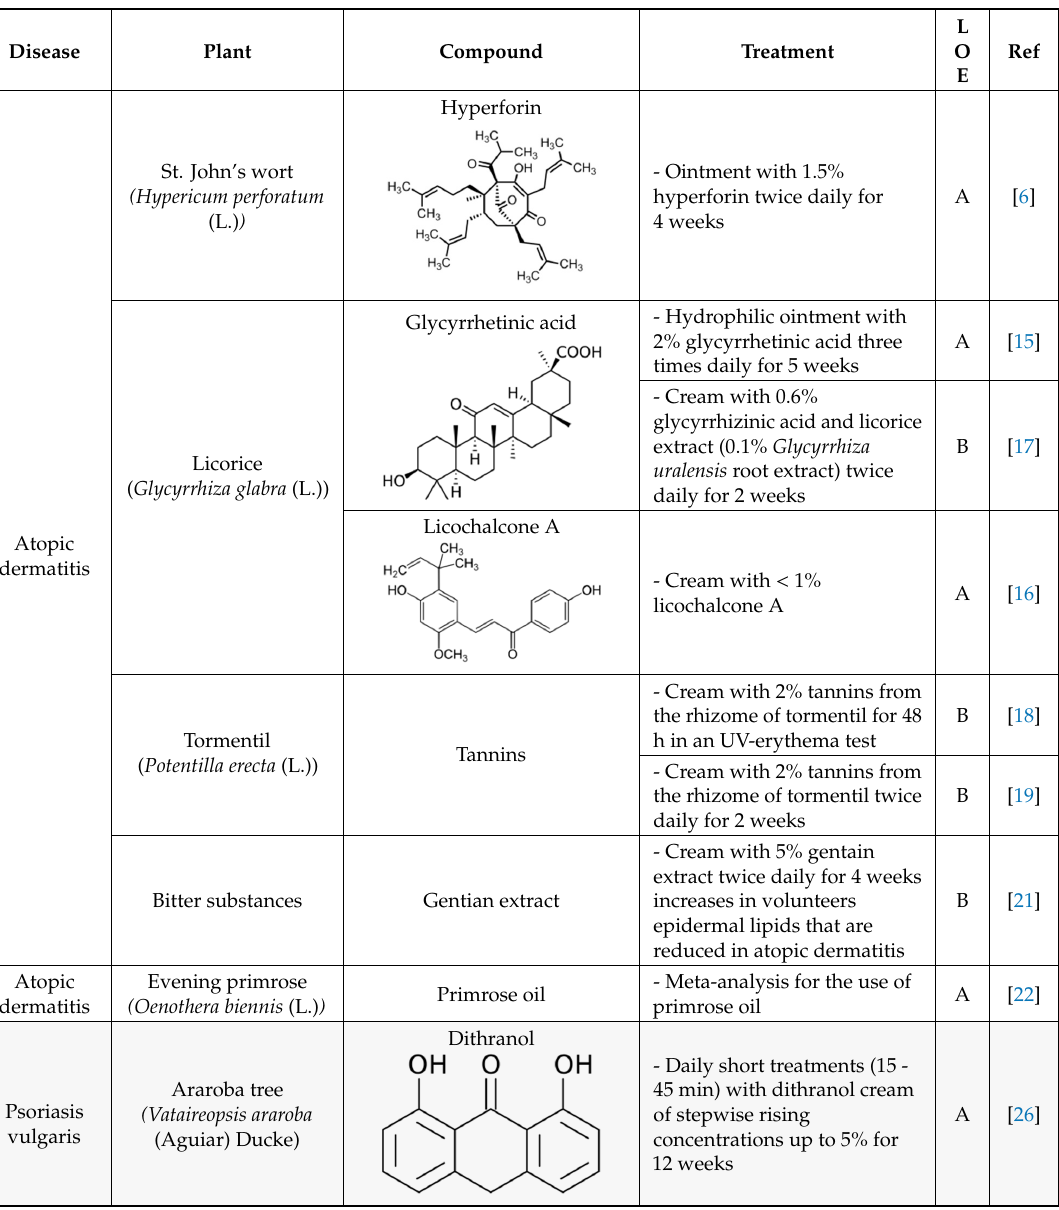
Table 1. Summary of herbal compounds for the treatment of skin